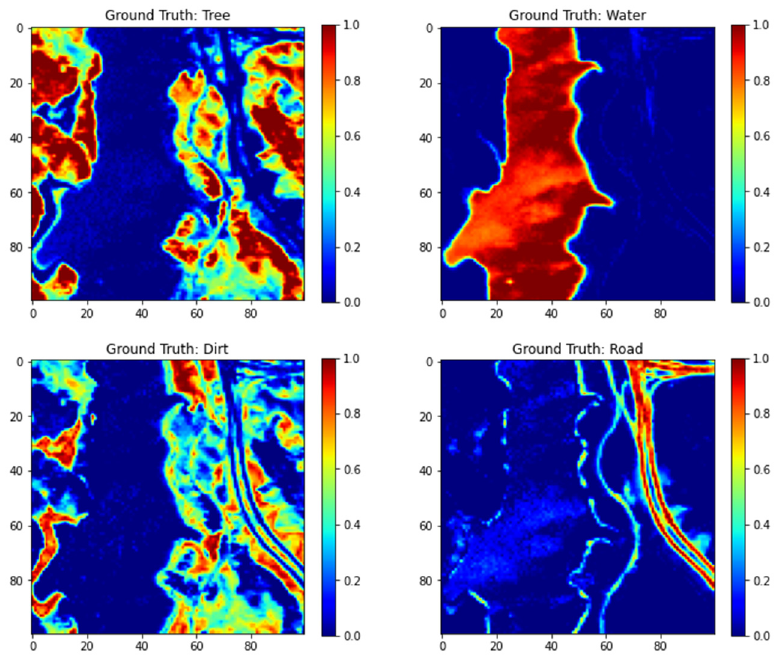
Figure 4. Endmember abundances for the four endmembers for Jasper image.